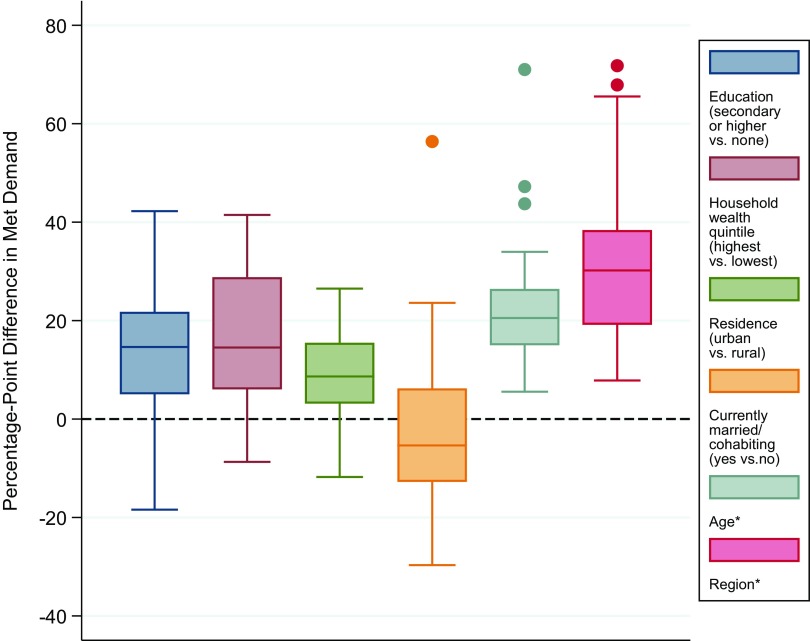
Boxplot Distribution of Within-Country Disparity in Family Planning Demand Met With Modern Methods (Percentage Point) Between the Most- and Least-Advantaged Subgroups,* by Background CharacteristicAll disparity measures are among women in union, except disparity by union status, which is among all women.Length of the box represents the interquartile range, the horizontal line in the box is median, the vertical line is a range of lower and upper adjacent values, and dots are outside values.Data were from the latest DHS from 55 countries.* Disparity by age or administrative unit represents the largest possible absolute gap among all subgroups.